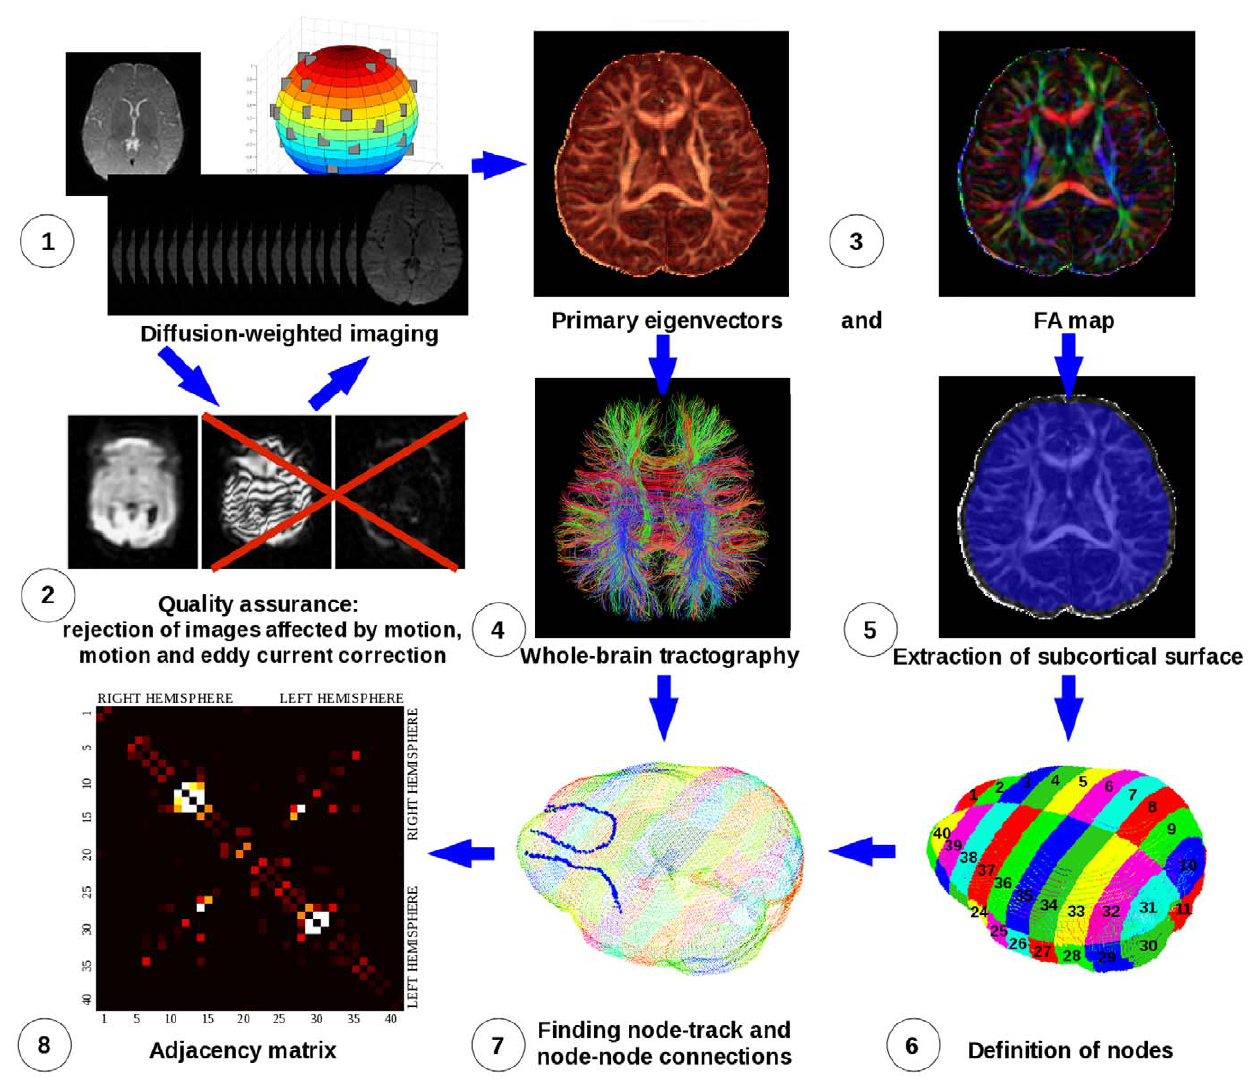
Figure 1. Flowchart: Assembling a Baby Brain Structural Network. After a set of diffusion-weighted images is acquired (1), a quality assurance step is performed in which data affected by motion are rejected and the remaining images are corrected for eddy current distortions and affine head motion (2). Although this step may not be necessary in cooperative adults, it is essential for high-quality tractography in infants. The diffusion tensor is calculated for the resulting data (3), and whole-brain streamline fiber tractography is undertaken (4). The subcortical surface is extracted (5) and partitioned into nodes using either the gridded or equipartition parcellation scheme (6, see below). Node-track and node-node connections are derived (7) and the adjacency matrix is constructed